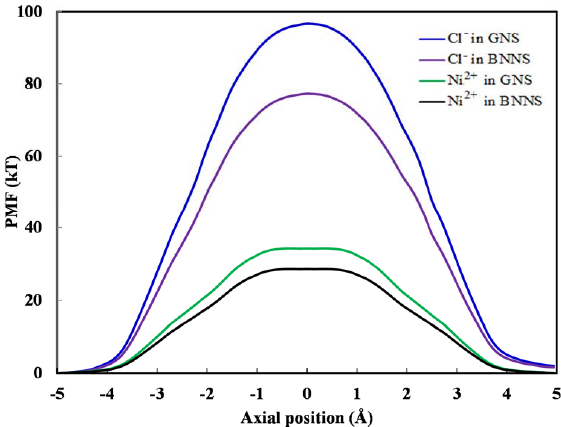
Fig. 3: The PMF for Ni 2+ and Cl - ions in the GNS and BNNS systems. Figure 3. The PMF for Ni 2+ and Cl - ions in the GNS and BNNS systems.